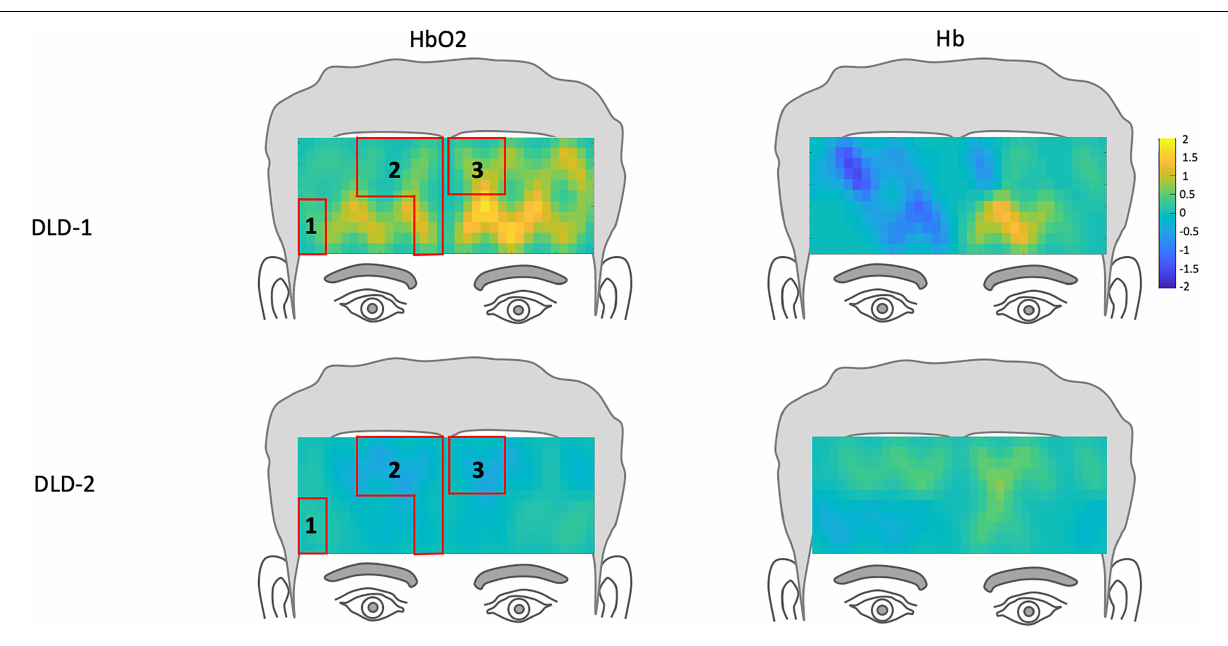
FIGURE 6 | Z -score topographs for DLD-1 and DLD-2 from post-training, for high-frequency words for HbO 2 and Hb. ROIs established by the normal controls are outlined in